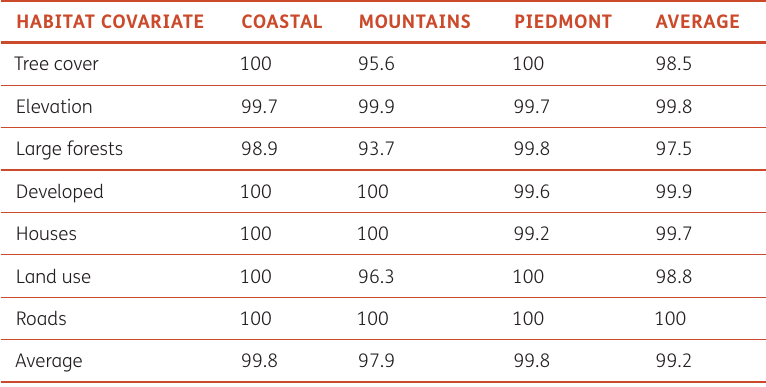
Table 4 Percentage of the area in three ecoregions of the state adequately sampled (>40 sites) by camera traps in the North Carolina’s Candid Critters(NCCC) project across seven habitat dimensions. See Table 3 for an example of how this was estimated for one habitat/ ecoregion and Appendix 1 for all